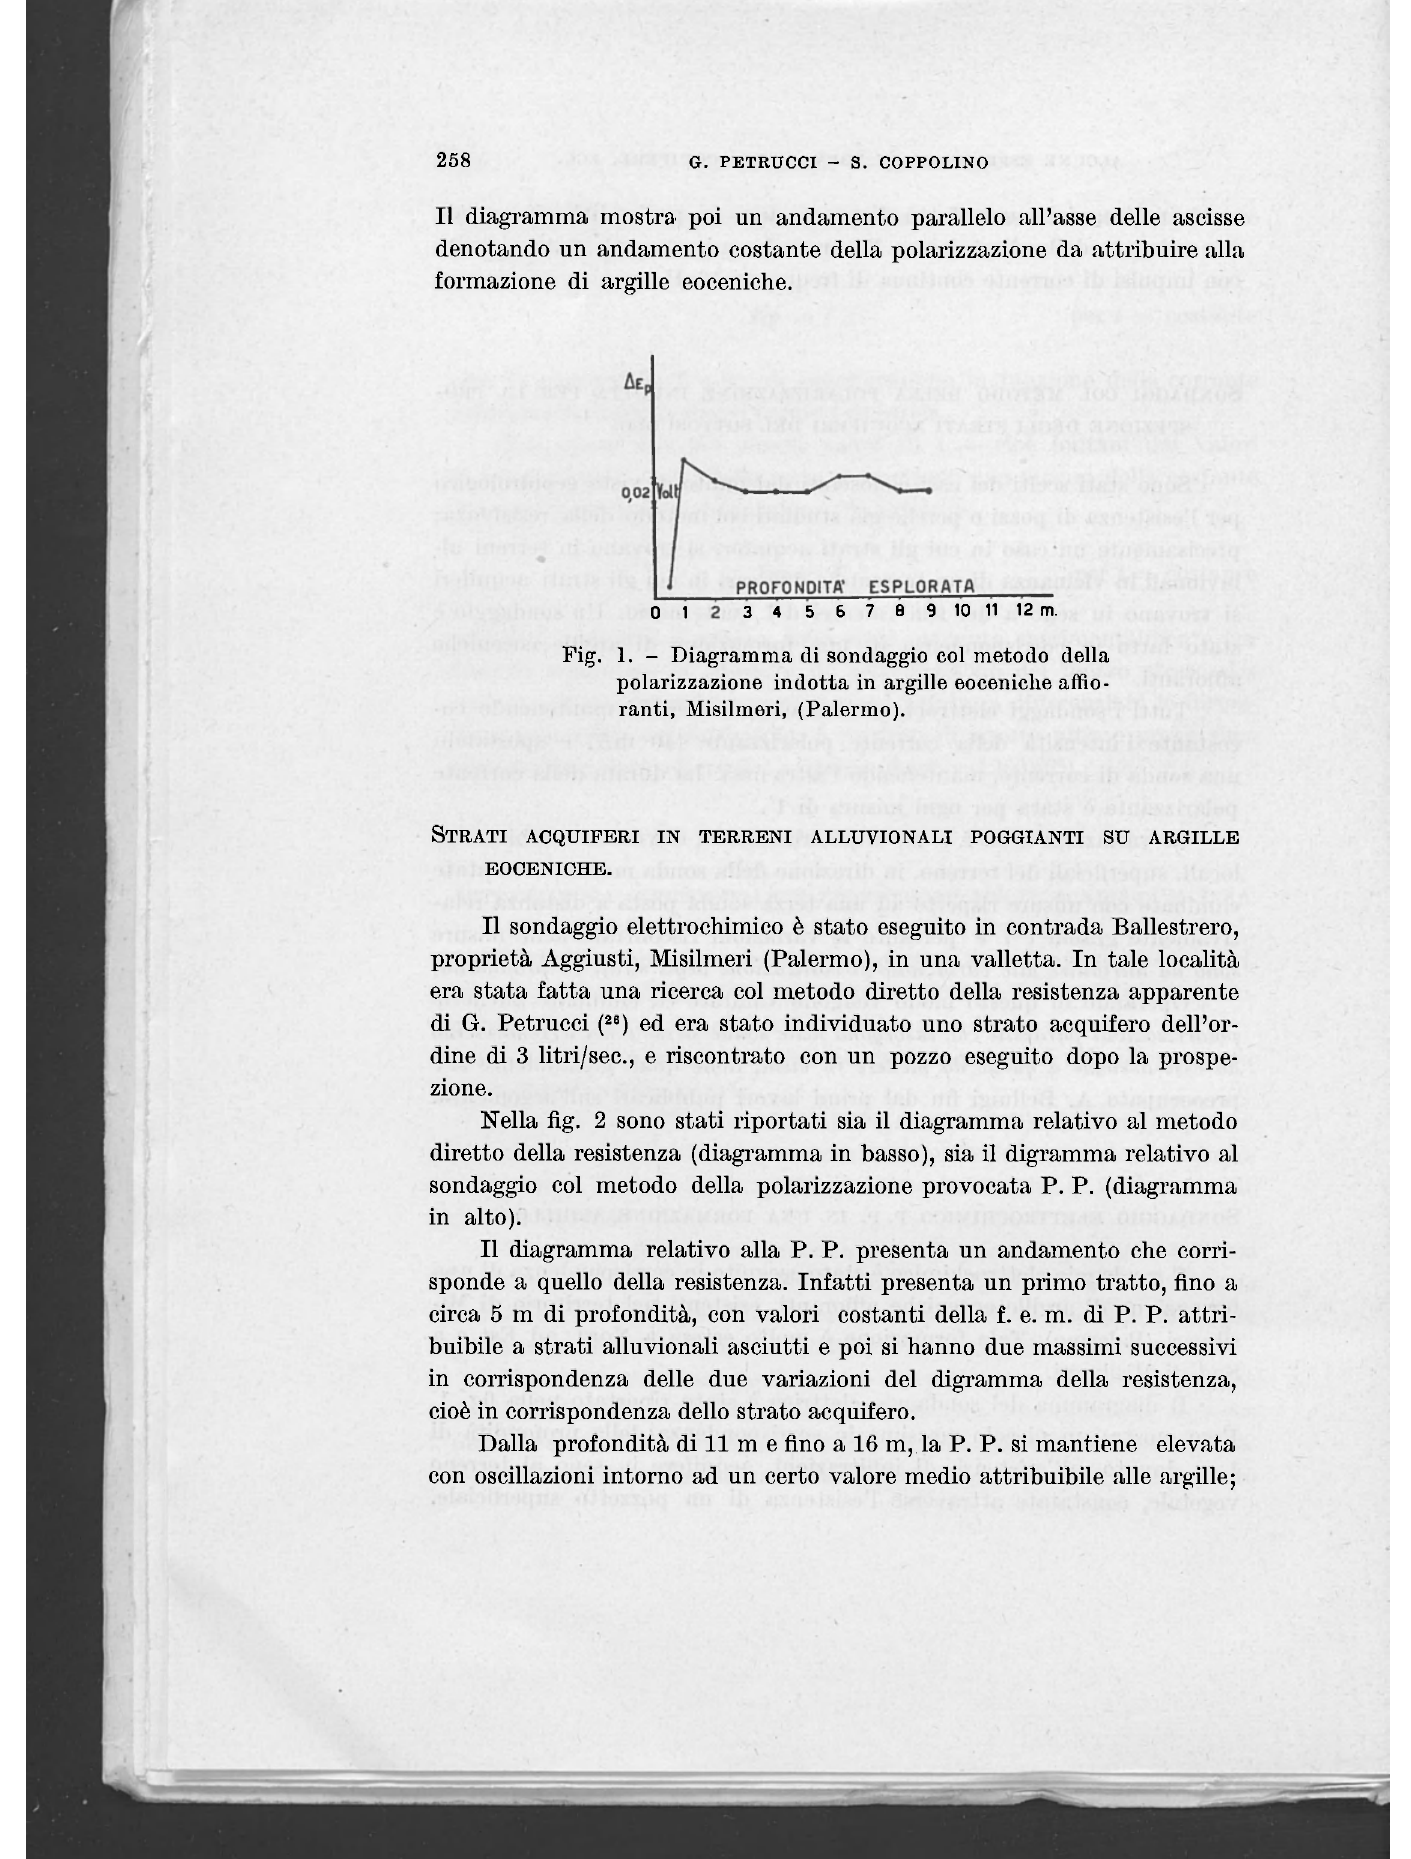
Fig. 1. - Diagramma di sondaggio col metodo della polarizzazione indotta in argille eoceniche affio- ranti, Misilmeri,